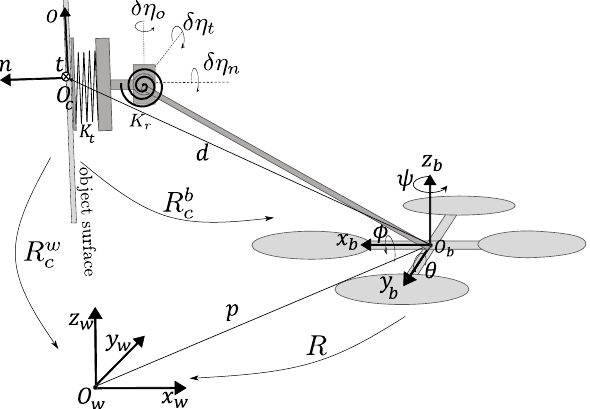
Figure 3. The coordinate frames, and components in the dynamic model of the aerial manipulator in contact with an